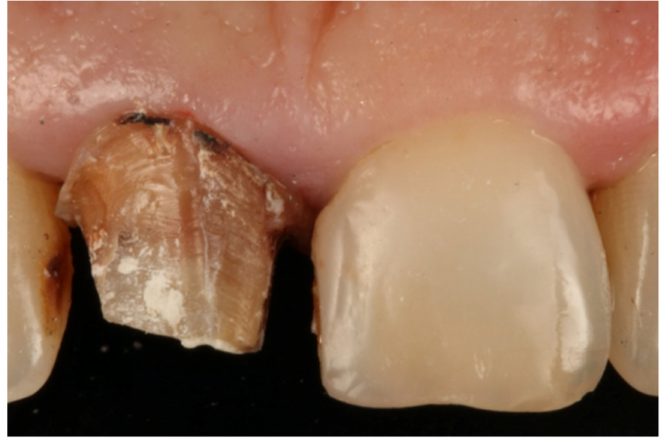
Figure 2. Horizontal finish line after removing the old restoration.